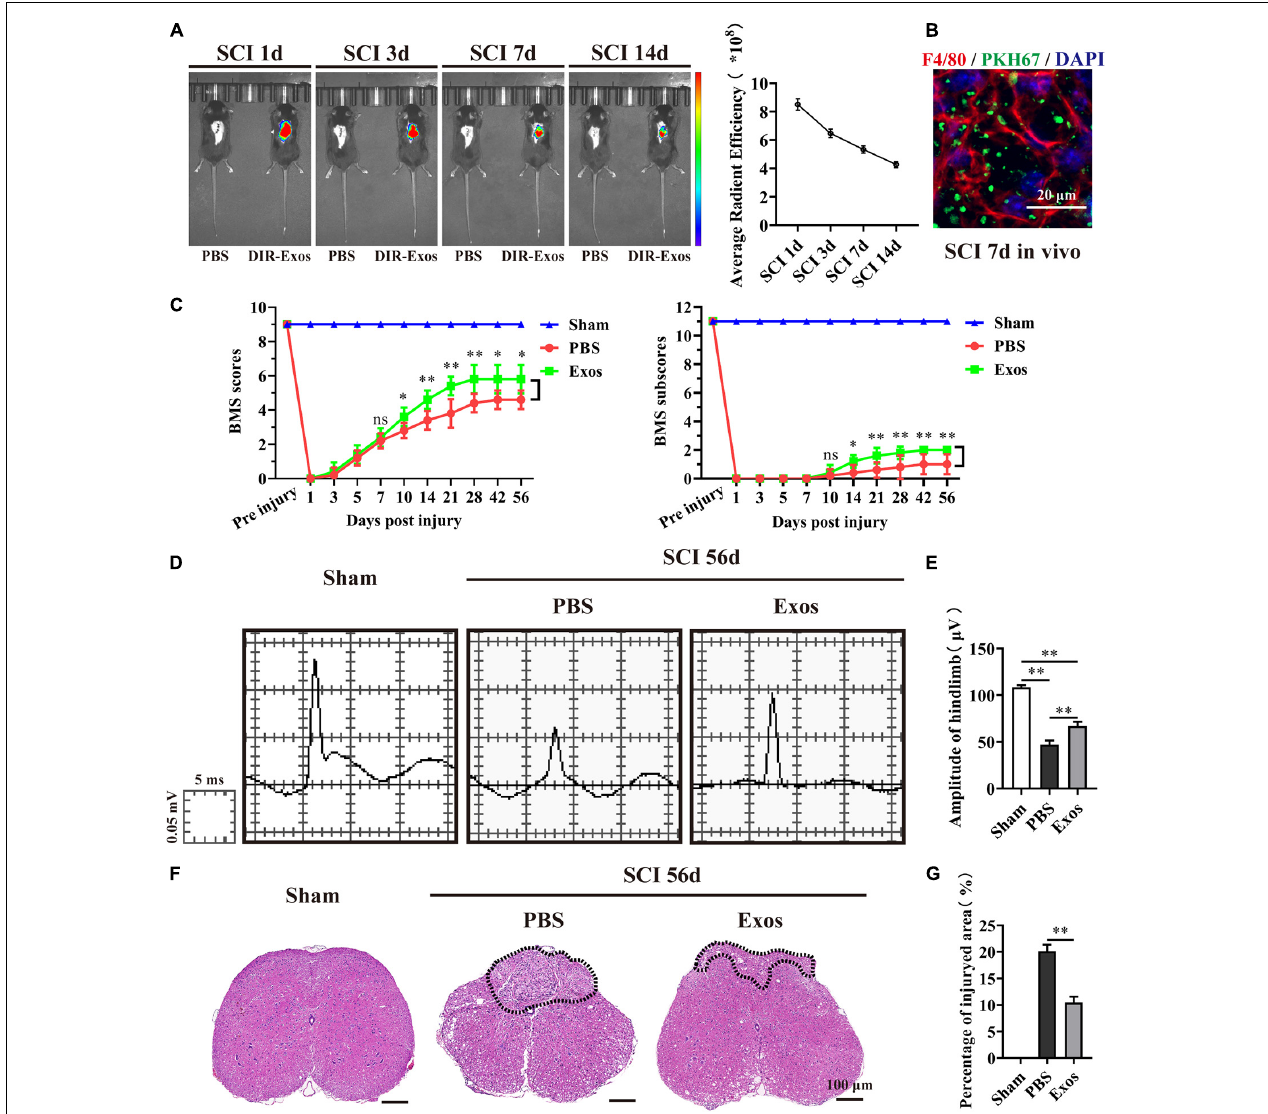
FIGURE 2 | Bone marrow mesenchymal stem cell-derived exosomes (BMSC-Exos) improved neurological functional recovery and tissue repair after spinal cord injury. (A,B) In vivo tracing of DiR or PKH67-labeled exosomes (Exos) in the injured spinal cord. (C) Basso Mouse Scale (BMS) scores and subscores over time post-spinal cord injury (post-SCI) in the sham, phosphate-buffered saline (PBS), and Exos groups. (D) Representative images of motor evoked potentials (MEPs) in the sham, PBS, and Exos groups at 56 days post-SCI. (E) Quantification of (C) ( n = 5 per group, values are the mean ± SD, ∗ p < 0.05, ∗∗ p < 0.01, one-way ANOVA). (F) H&E staining of injured spinal cords in the sham, PBS, and Exos groups at 56 days after SCI. The black dashed line outlines the injured sites. Scale bar = 100 µ m. (G) Quantification of (F) ( n = 5 per group, values are the mean ± SD, ∗ p < 0.05, ∗∗ p < 0.01, two-tailed Student’s t